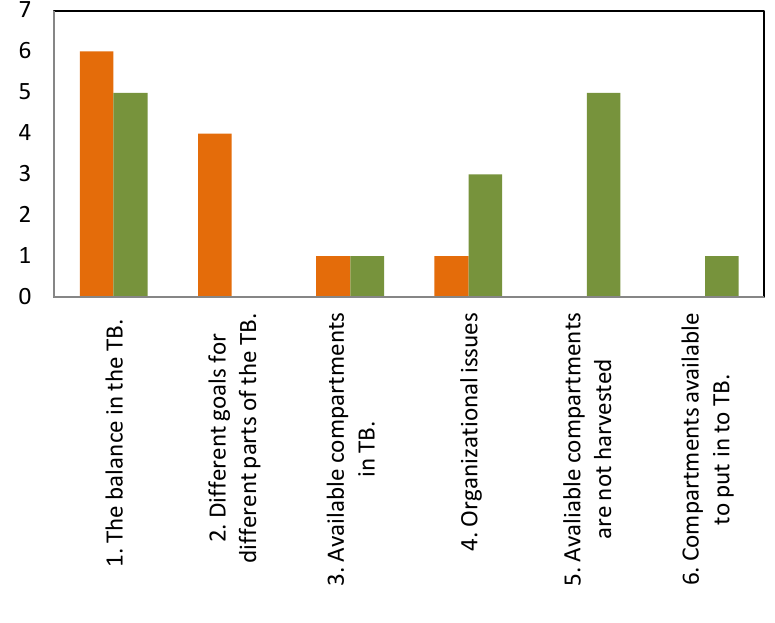
Figure 4. Factors mentioned in open-ended comments about the size of the